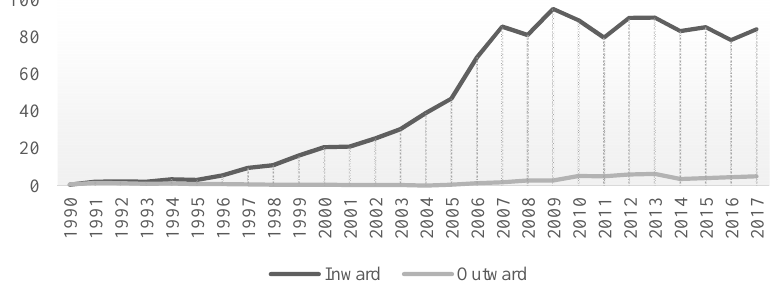
Source: Eurostat. Figure 2. Changes in the FDI in Bulgaria (stock) as % of